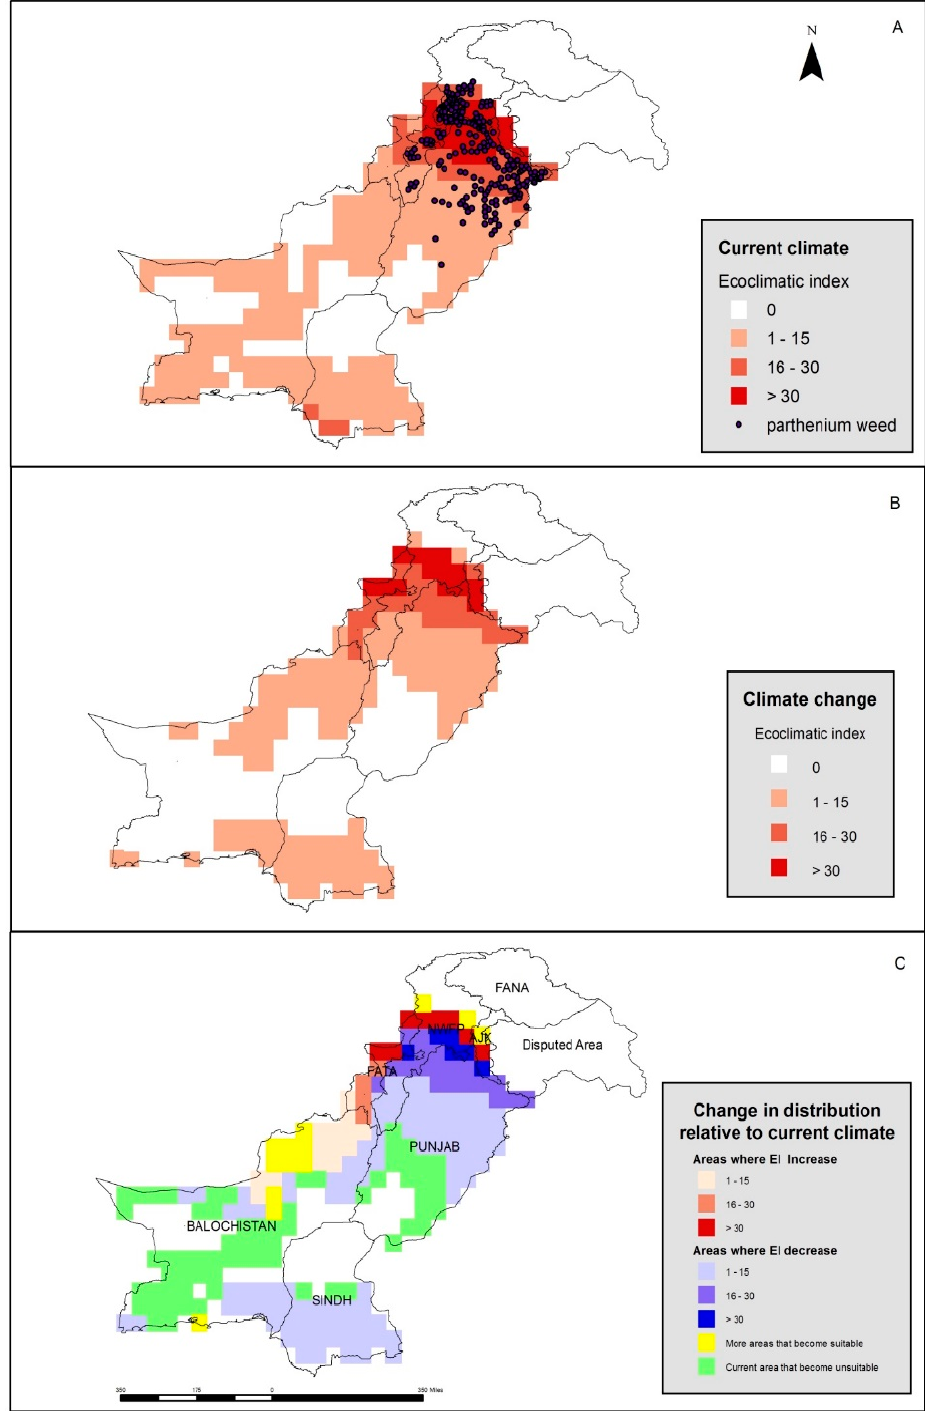
Figure 3. The current distribution of (black dots) and climatic suitability (colored squares) for parthenium weed in Pakistan under ( A ) the current climate, and under ( B ) a changed climate with a change of +3°C. The change in distribution, relative to the current climate ( C ), has been determined using CLIMEX.